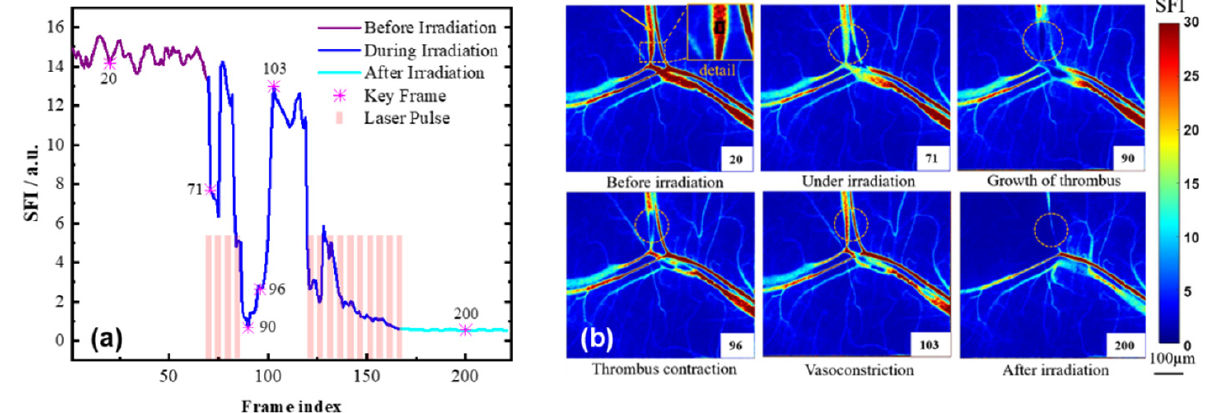
Figure 12. Blood-flow monitoring during laser irradiation using SFI. ( a ) The relationship between SFI and frame index, ( b ) SFI images at important instants (Video S1).